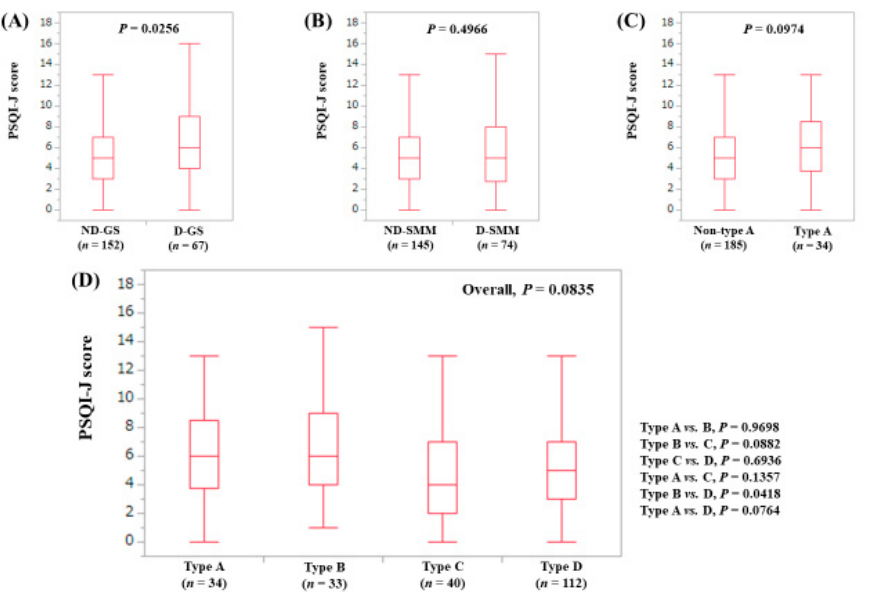
Figure 6. PSQI-J score stratified by GS and SMM for female cases ( n = 219). ( A ) Non-decreased GS vs. Figure 6. PSQI ‐ J score stratified by GS and SMM for female cases ( n = 219). ( A ) Non ‐ decreased GS vs. decreased GS. ( B ) Non-decreased SMM vs. decreased SMM. ( C ) Non-type A (type B, C and D) vs. type decreased GS. ( B ) Non ‐ decreased SMM vs. decreased SMM. ( C ) Non ‐ type A (type B, C and D) vs. A. ( D ) Comparison among four types (type A, B, C and D). type A. ( D ) Comparison among four types (type A, B, C and D).